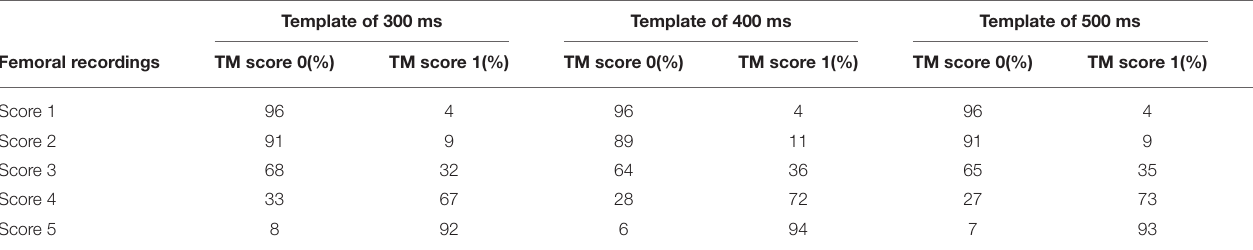
TABLE 3 | Confusion matrices of signal classification done by the hand-engineered classification model constructed with template matching. Template of 300 ms Template of 400 ms Template of 500 ms Femoral